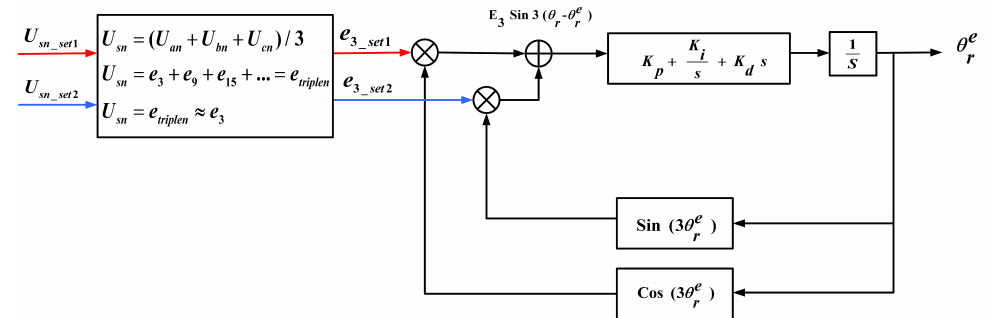
Figure 5. EKF-based rotor position estimator for DTP Machines